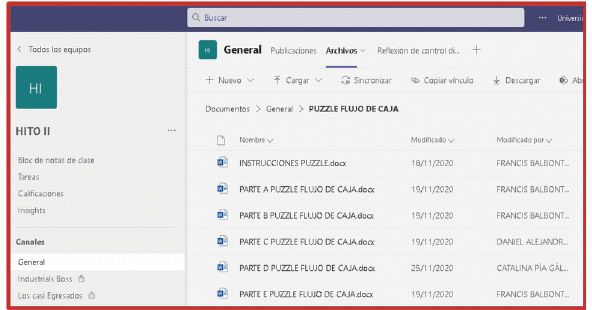
Figure 14. Cash Flow Puzzle